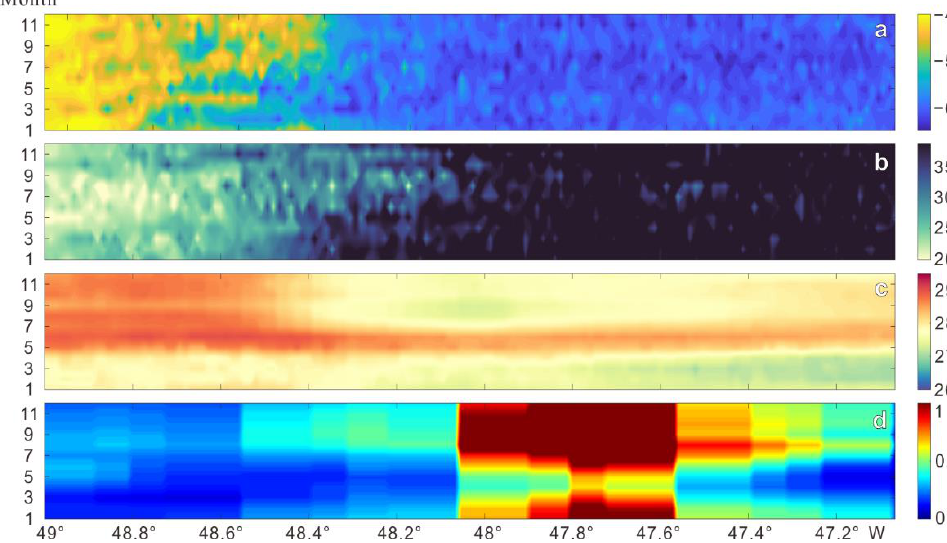
Figure 7. Ten-year averaged monthly variations of various elements along transect M. ( a ) Water remote-sensing reflectance (R rs , to represent the SPM; unit: lg(sr − 1 )); ( b ) sea surface salinity (SSS; unit: PSU); ( c ) sea surface temperature (SST; unit: °C); ( d ) ocean current velocity (unit: m/s). The ordinate is the month (January – December) and the abscissa is the longitude.